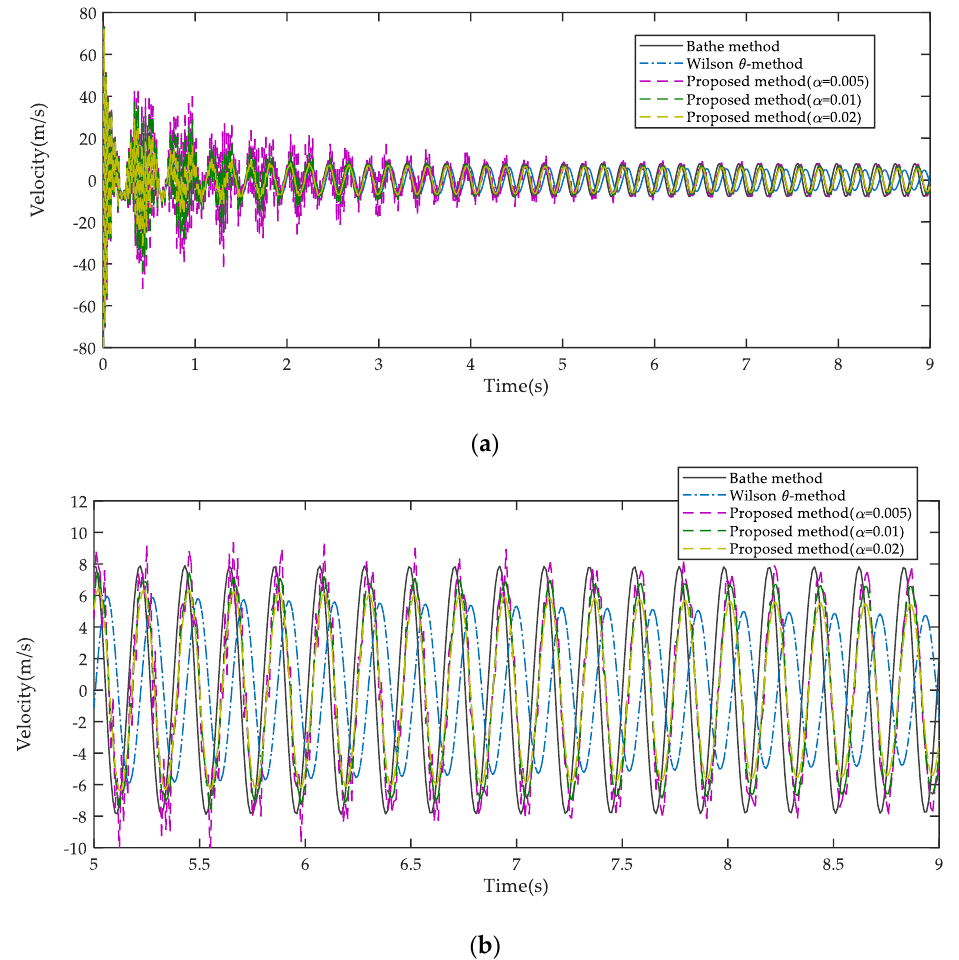
Figure 18. Velocity responses of Point A with the Wilson method, Bathe method, and the proposed method when ∆ t = 0.01 s: ( a ) Global velocity responses. ( b ) Partial enlarged drawing of velocity responses.